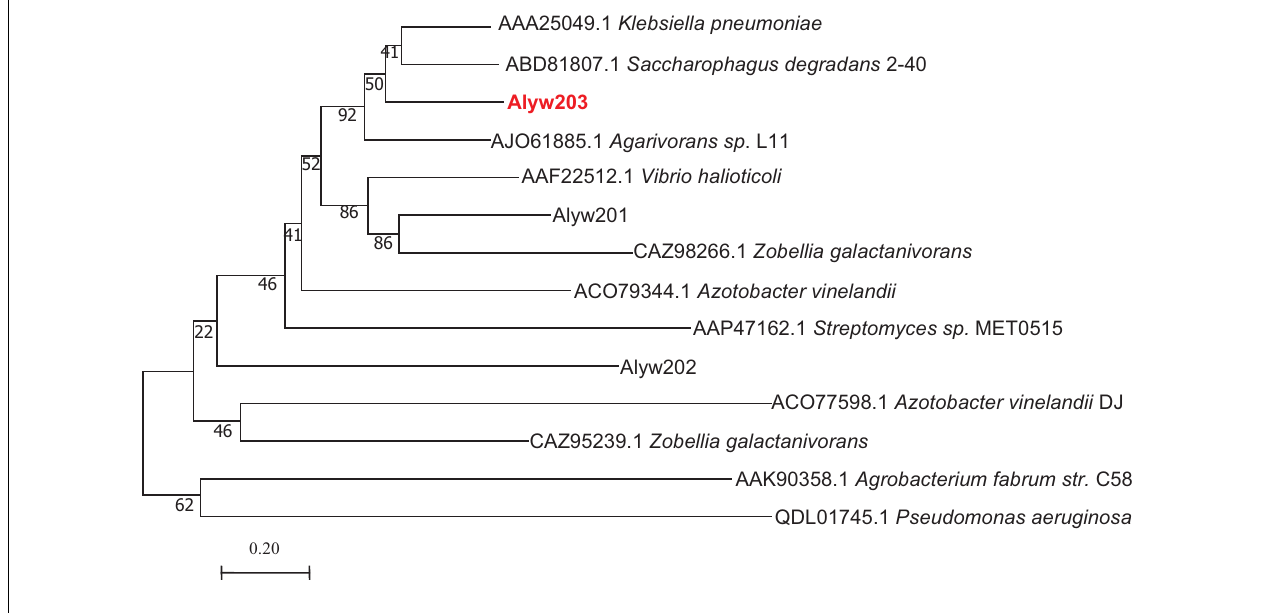
FIGURE 9 | Phylogenetic relationship of the Alyw203 with other reported alginate lyases. Phylogenetic tree generated according to the ITS rDNA gene sequences with the neighbor-joining method. The number listed first represents the serial login number. The branching correlation numbers are bootstrapped values (confidence limits) that represent the replacement frequency of each amino acid residue. TABLE 1 | Comparison of Alyw203 performances with other alginate